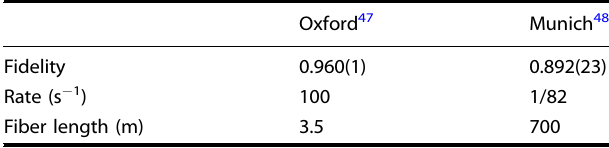
Fig. 5 Schematic of the memory-based DI-QKD implementations reported in refs. 47,48 . Alice and Bob are situated at distant locations and equipped with an input generator, storage and process unit, and a device containing a single ion or atom quantum memory. The memories are entangled as follows. First, via spontaneous decay entangled atom-photon pairs are generated in each device. The photons are collected into fi bers that guide them to a Bell-state measurement (BSM) setup. There, they interfere at a beam splitter (BS) where in each output port the photon polarization is analysed with a polarizing BS (PBS) and two single photon detectors (SPD). The entanglement generation tries are repeated till a photonic coincidence detection occurs and heralds shared entanglement between the quantum memories. Next, the DI-QKD protocol starts with a random seed from the input generators to select the measurement orientation, perform the measurement, and output the result. These measurement in- and outputs of every round are stored in a local storage. The storage and processing unit are connected via an authenticated classical channel to facilitate the post-processing steps of the key generation Table 1. Performance of the quantum links.